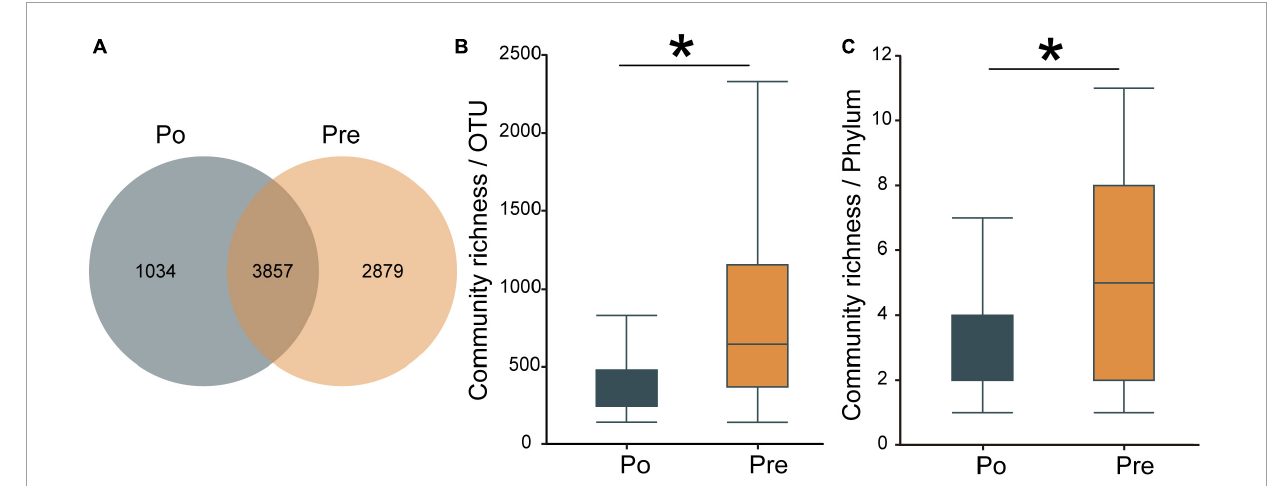
FIGURE1 Diversity of the vaginal microbiota. Venn diagrams for overlap between the pre-operative observed OTUs versus post-operative group observed OTUs. Pre contained 6,736, and Po contained 4,891, among which 3,857 were shared between the two groups (A) . The α -diversity of the microbiota was calculated in OTUs level (B) and phylum level (C) by the species richness index. The pre-operative group (Pre); post-operative group (Po). * p < 0.05.